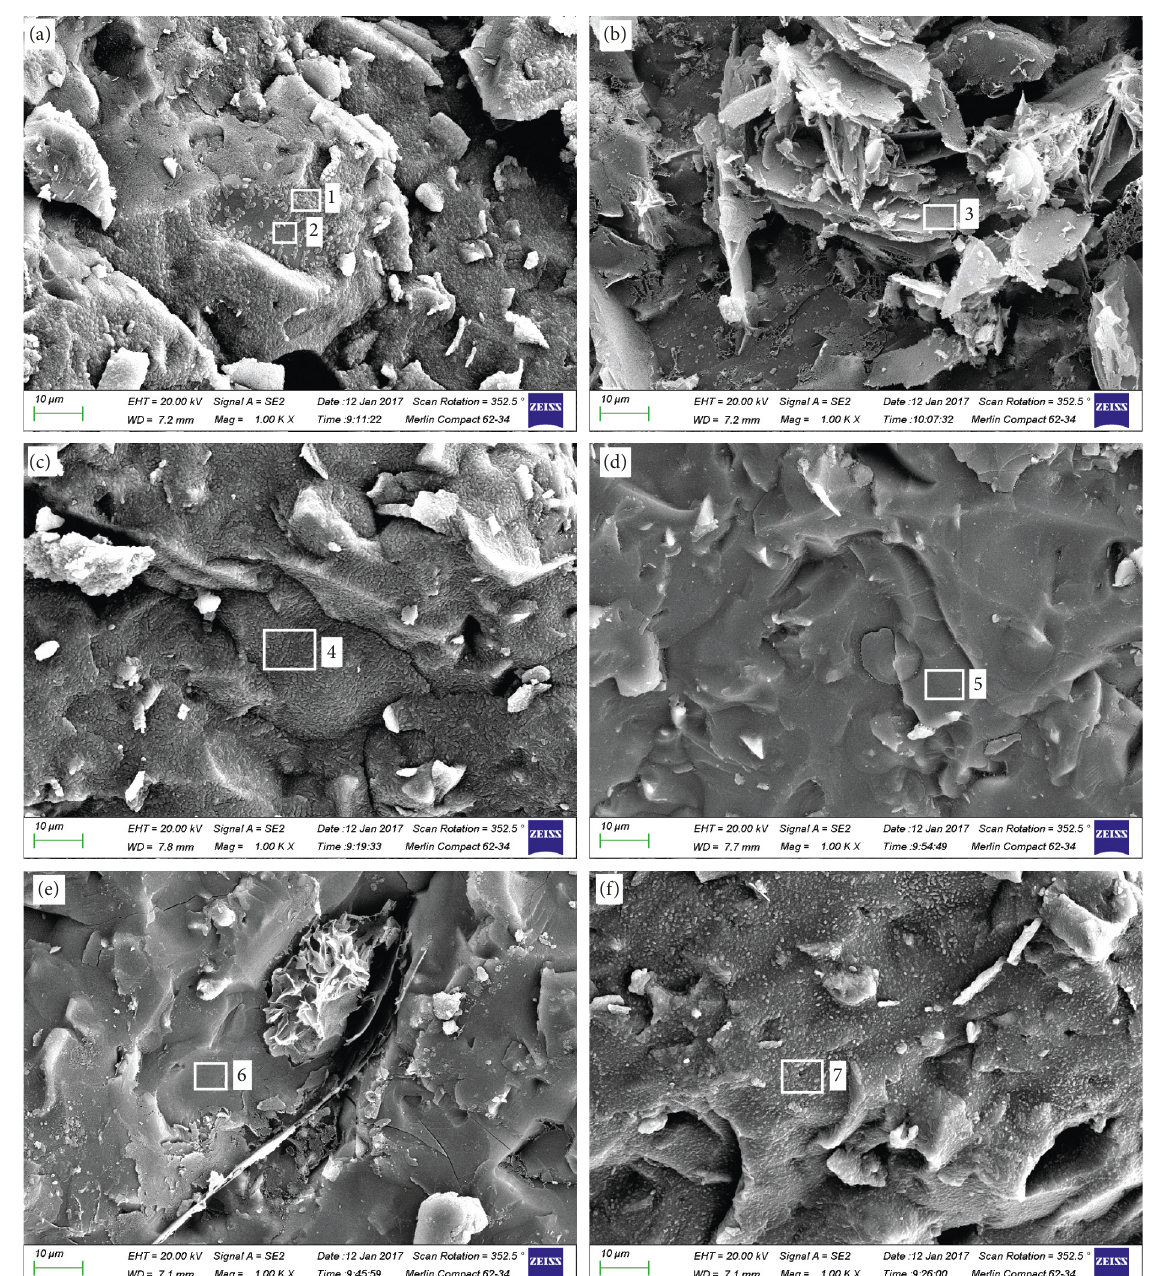
Figure 8: SEM images of AAS pastes for 28 days: (a) M1.2N6. (b) M1N8. (c) M1.2N8. (d) M1.4N8. (e) M1.6N8. (f)